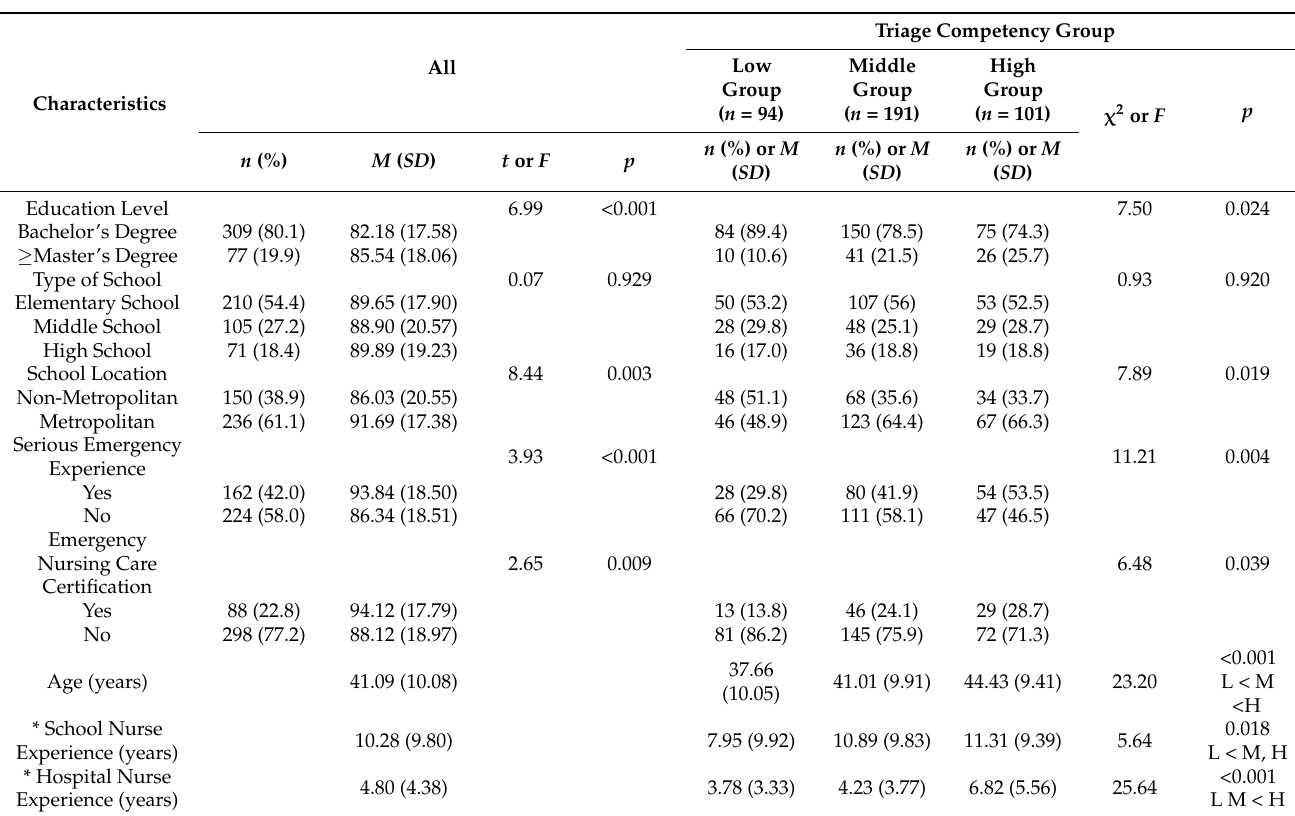
Table 1. Differences in triage competency with respect to the participants’ general characteristics and work experience ( n = 386).